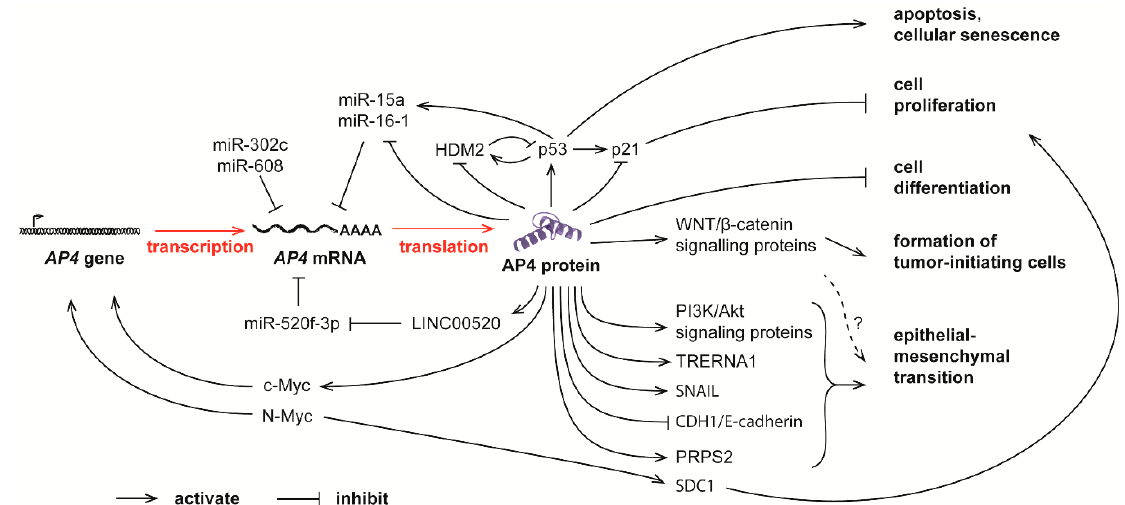
Figure 2. Complex feedback loops between AP4 and many other molecules in controlling normal physiological processes and tumor progression. The mRNA level of AP4 is controlled by c-Myc and N-Myc, as well as several miRNAs. Elevated AP4, in turn, promotes cell proliferation, apoptosis, senescence, tumor-initiating cell formation, and epithelial-mesenchymal transition (EMT).